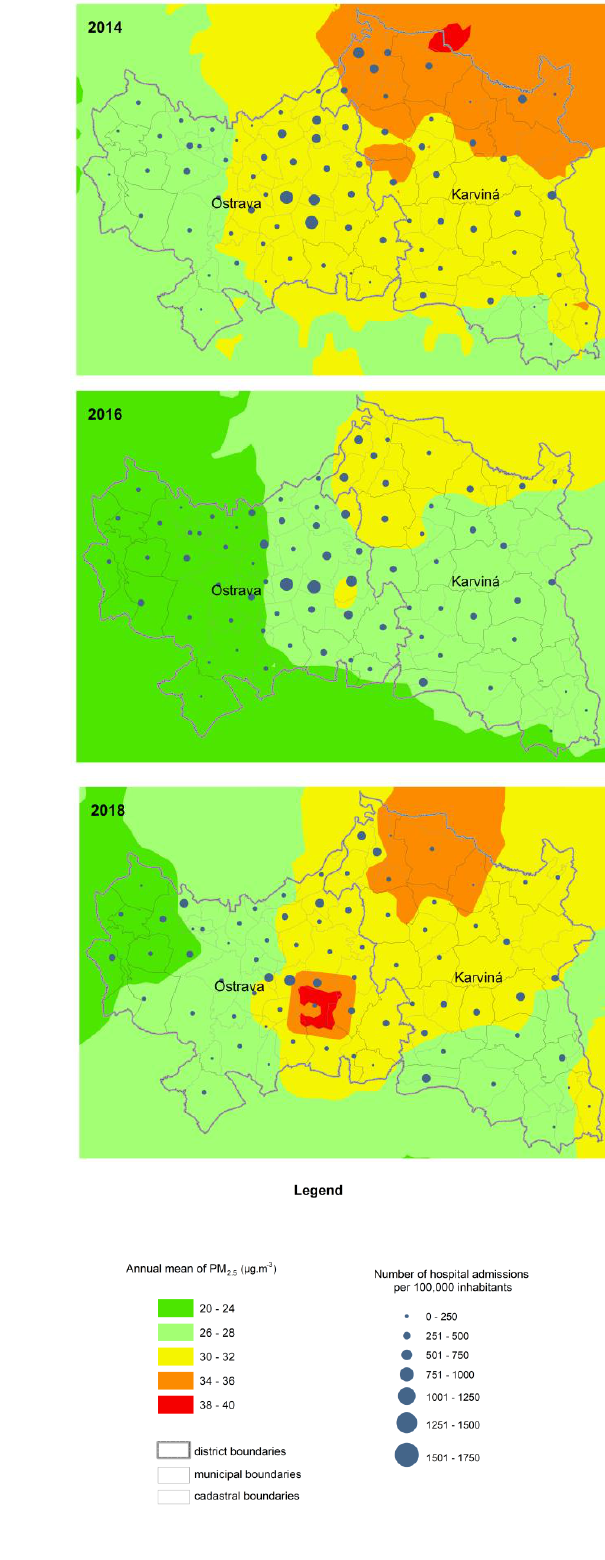
Figure 3. Hospital admissions for respiratory diseases (J00-J99) per 100,000 population during individual years of the study period.